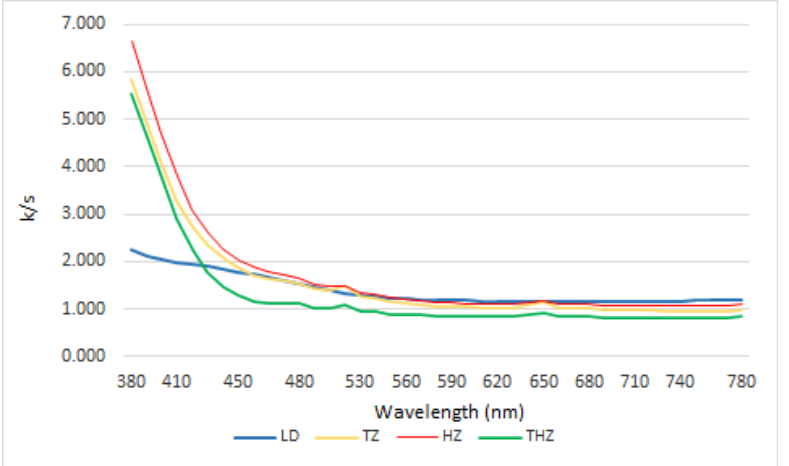
Figure 2. Spectral distribution of the K/S ratio for three zirconia and lithium disilicate. Wavelength range from 380 to 780 nm.